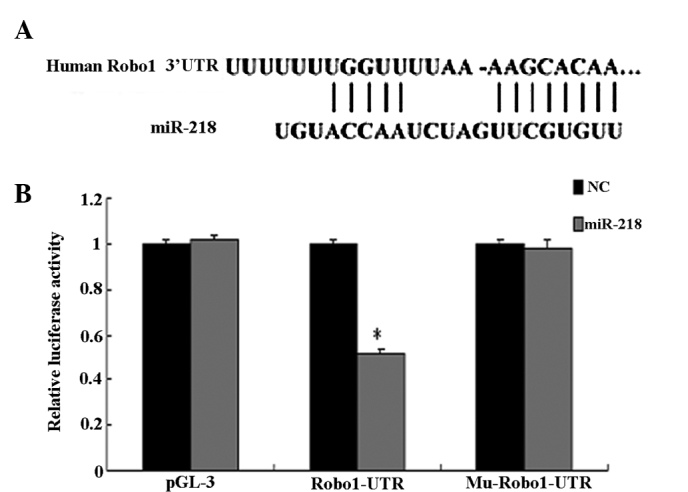
Robo1 is a direct target of miR-218. (A) Identification of target sites in the 3′-UTR of Robo1 was performed using TargetScan. (B) A luciferase assay was performed to determine the target association in U87 cells transfected with the control pGL-3 vector, a vector containing the Robo1 sequence that was predicted to interact with miR-218 (Robo1-UTR) or a vector containing a mutated Robo1 sequence with the predicted target sites (Mu-Robo1-UTR). The reported data are representative of at least three independent experiments. *P<0.05. Robo 1, roundabout, axon guidance receptor, homolog 1; UTR, untranslated region; miR-218, microRNA 218; NC, negative control.